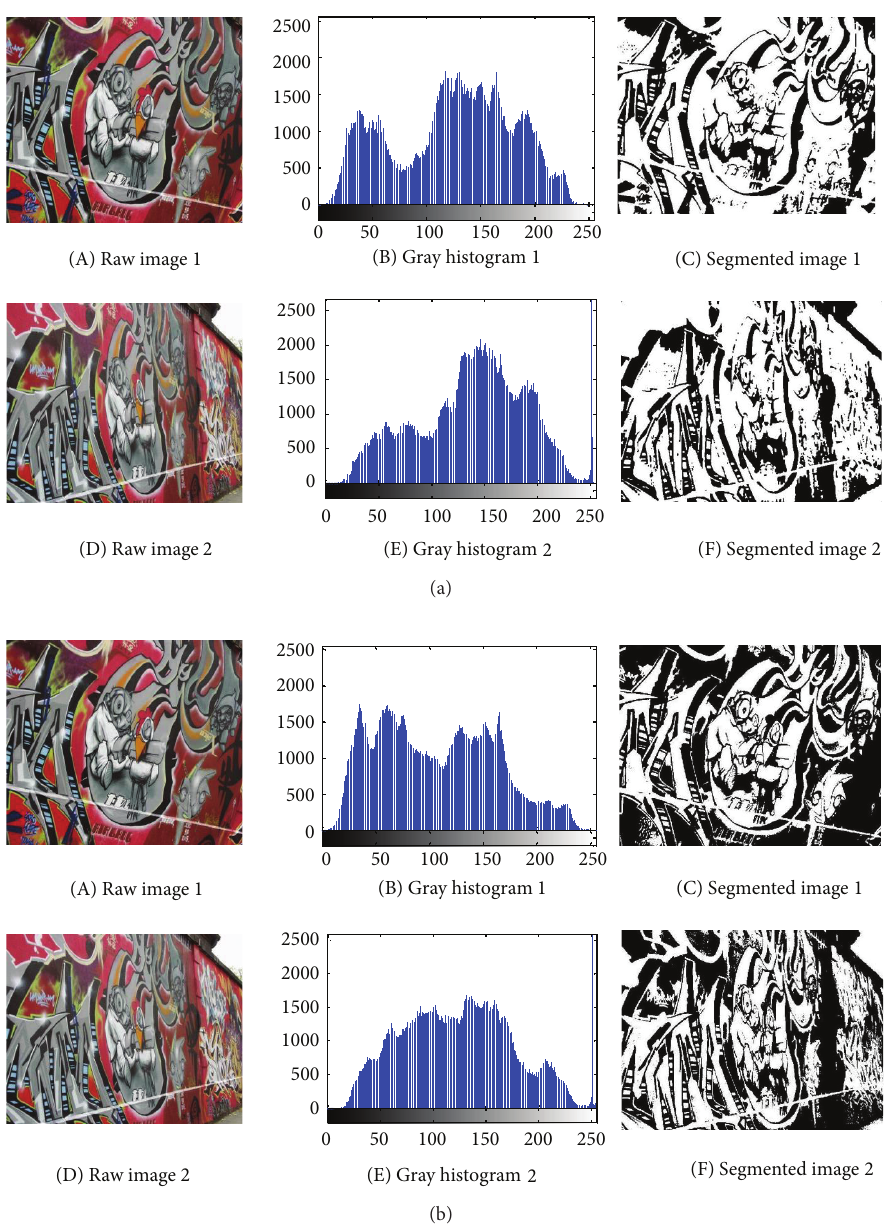
Figure 4: (a) Otsu segmentation on images in group 3. (b) 2DMETS on images in group